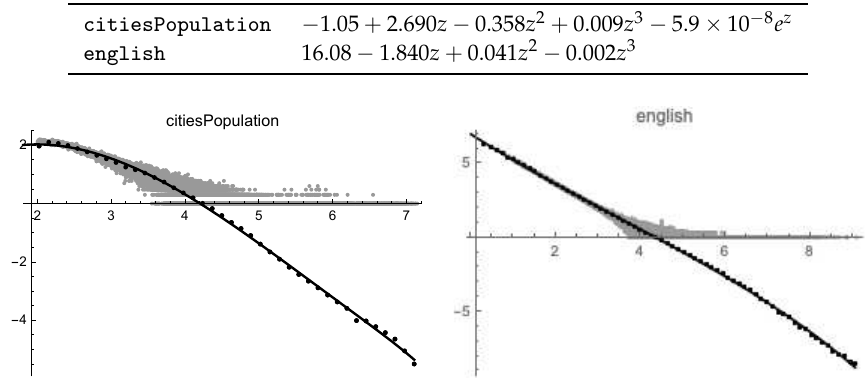
Table 2. Solutions of two selected scalar phenomena.